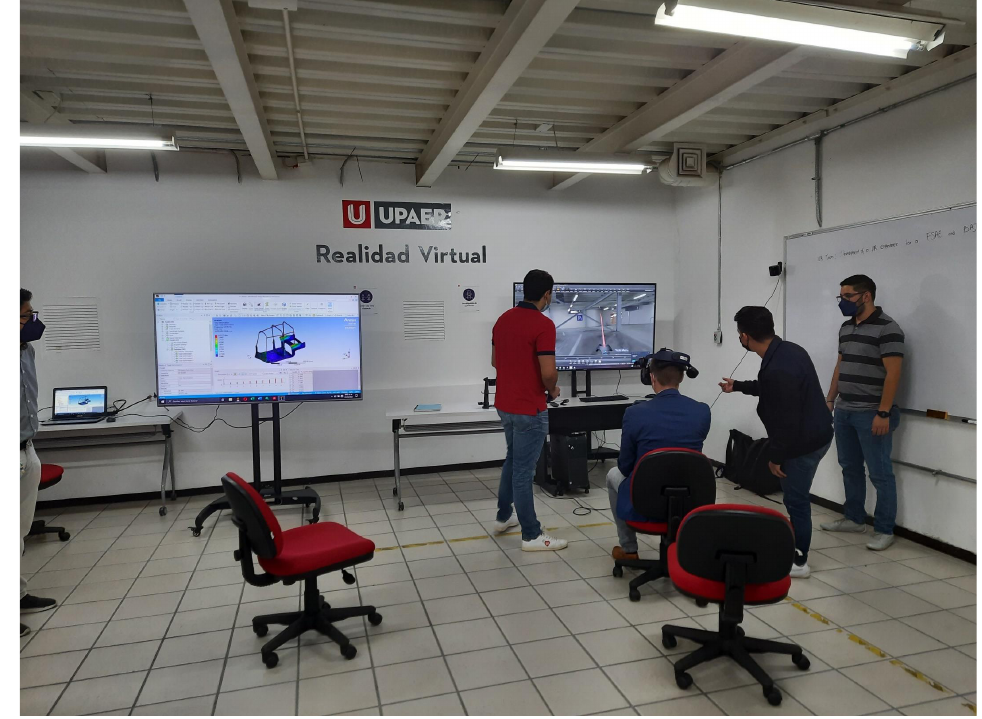
Figure 8. Development of courses and training at the VR/AR laboratory at UPAEP (2020–2022).